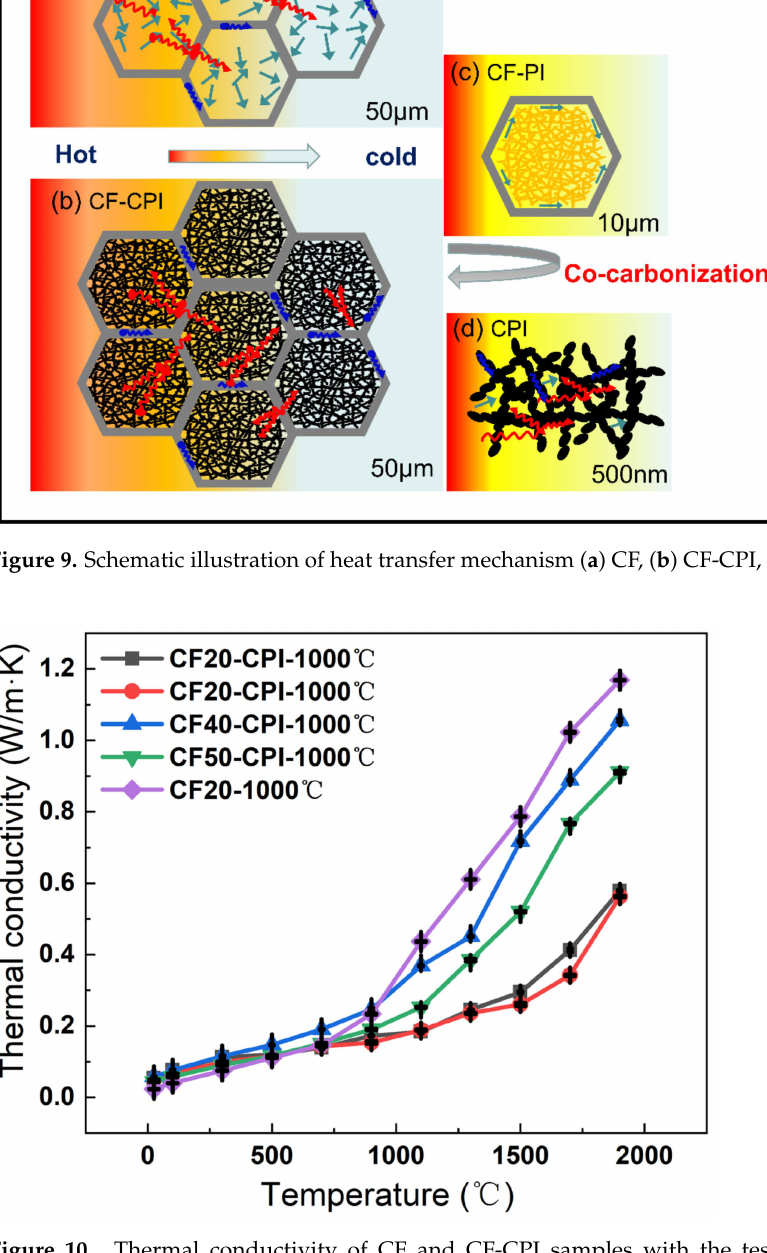
Figure 10. Thermal conductivity of CF and CF-CPI samples with the test temperature from 25 to 1900 ◦